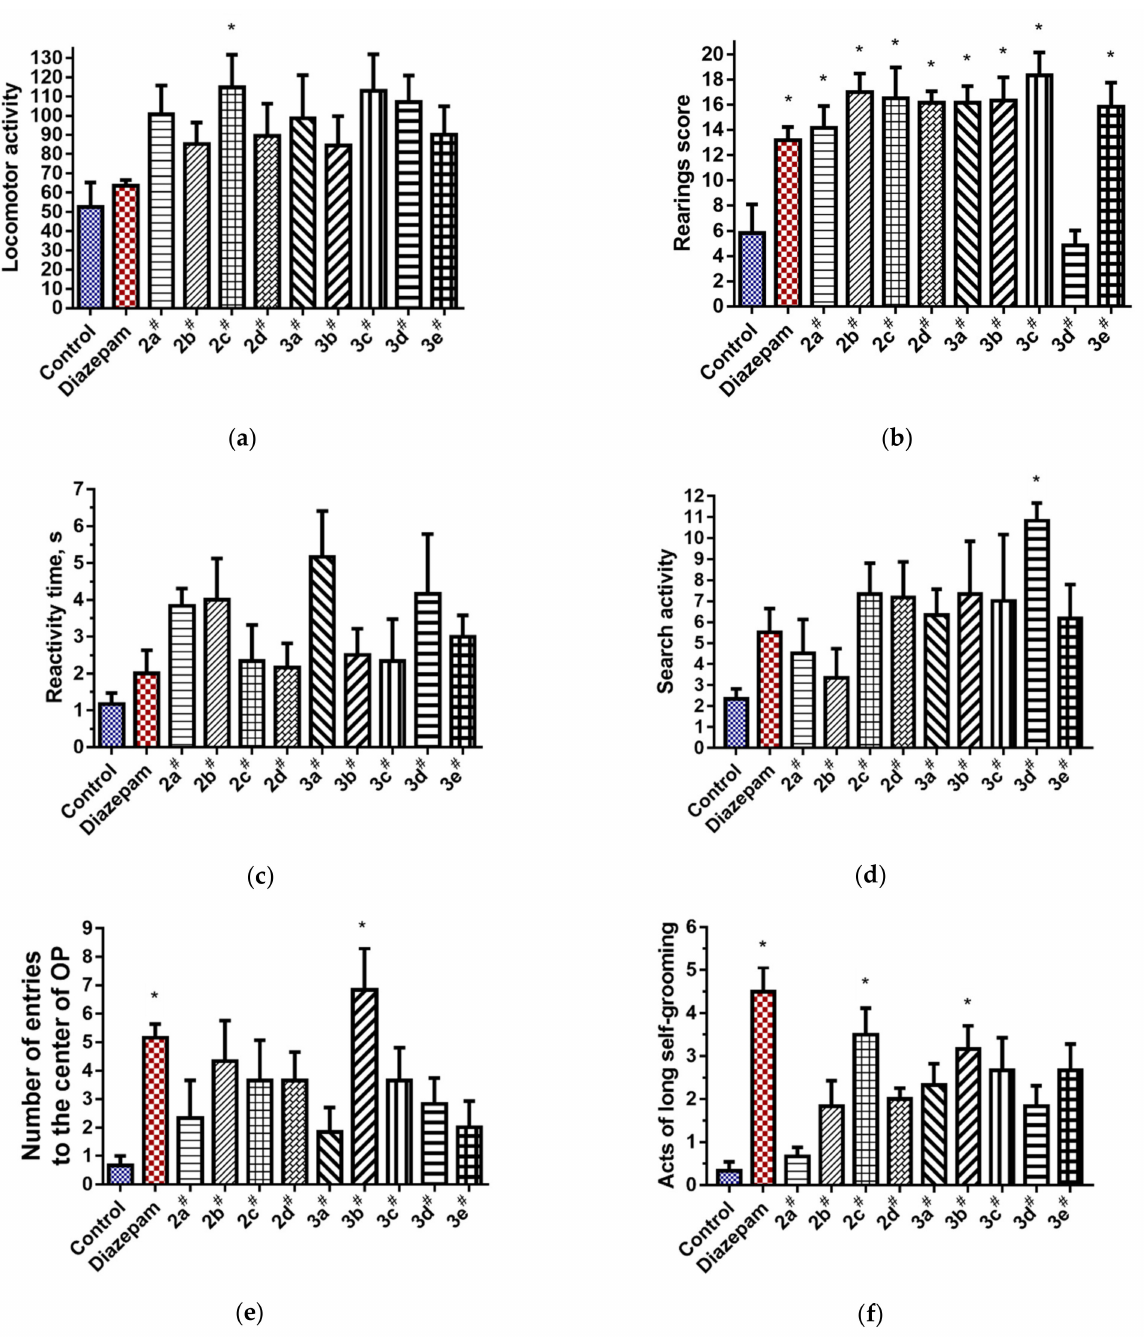
Figure 2. Behavioral activity in compounds 2 and 3 in Open Field test in comparison with diazepam (2 mg/kg), mice, per oral administration, M ± SEM; ( a ) locomotor activity of animals; ( b ) rearings score; ( c ) reactivity time; ( d ) number of holes explored; ( e ) number of entries to the center of open field; f) number of long self-grooming acts Note: * Data are comparable to the control group ( p ≤ 0.05, Kruskal–Wallis test post-hoc Dunn‘s test); # The dose is equimolar to diazepam at a dose of 2